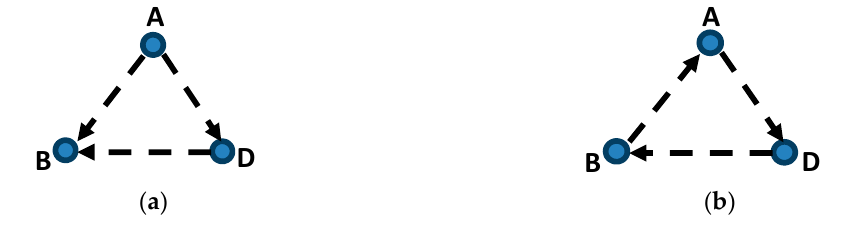
Figure 1. Form ( a ) and form ( b ) non-isomorphic graphs that are represented by K 3 in the underlying undirected graph representation.